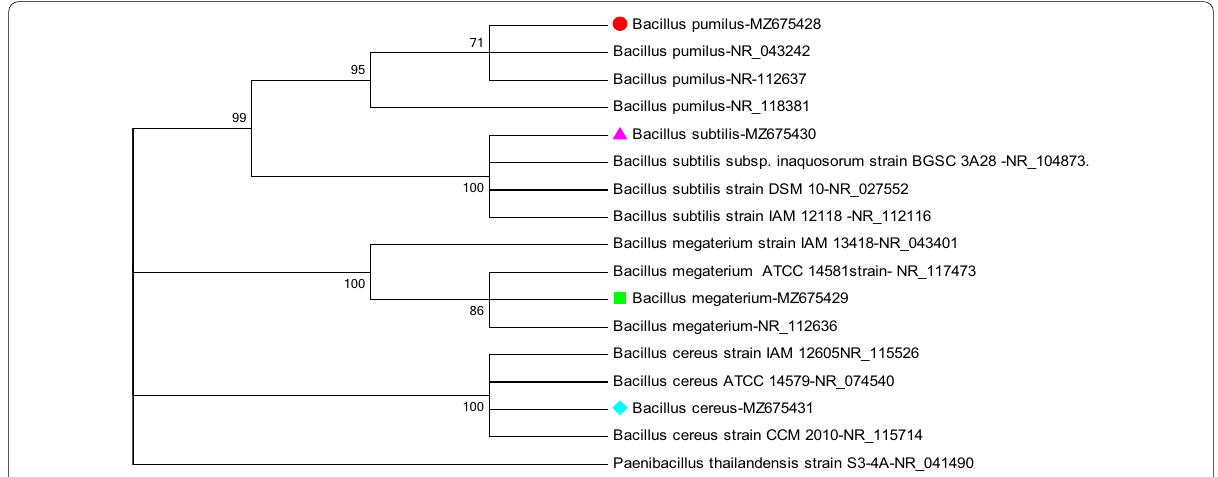
Fig. 2 Phylogenetic tree relationship of identified rhizobacterial isolates with selected reference strains